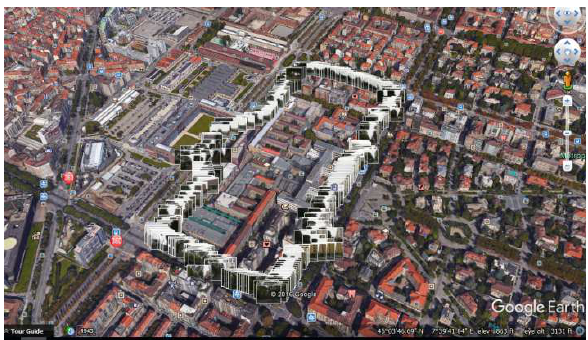
Figure 9. Data Collection Path along with geotagged photos in google